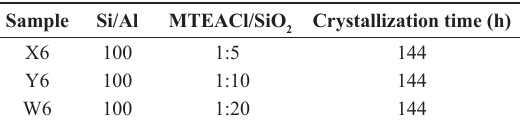
Table 1. Characteristics of the synthesized samples X6, Y6 and W6 from ZSM-12 samples. Sample